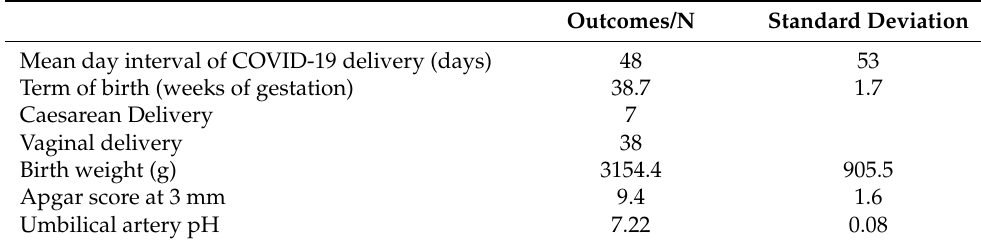
Table 4. Delivery of mothers COVID-19 and newborns outcomes.